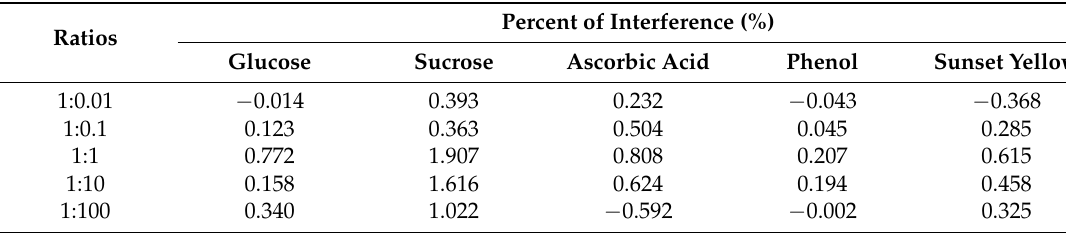
Table 1. Percent of interfering substance in enzymatic